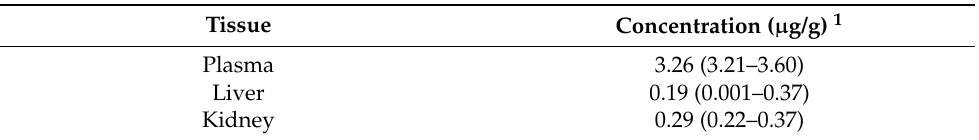
Table 3. Median (min, max) values of CP concentrations remaining in liver and kidney at 48 h post intramuscular administration (4 mg/kg), expressed as CP µ g per g of tissue.